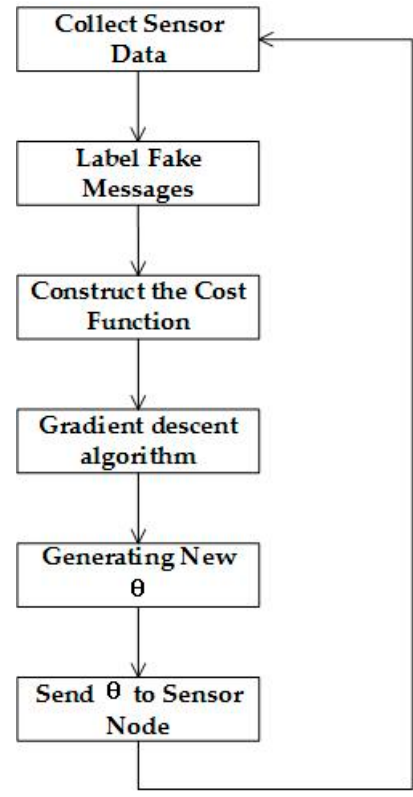
Figure 6. Supervised learning running in the sink node.